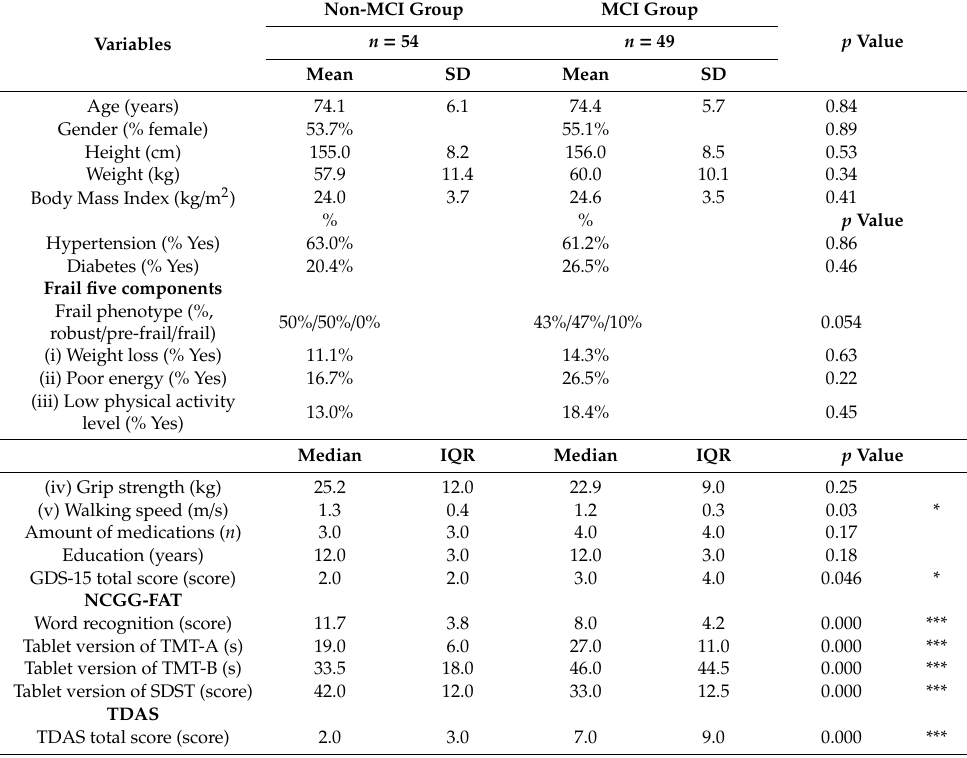
Table 1. Characteristics of participants with and without mild cognitive impairment (MCI). Non-MCI Group MCI Variables